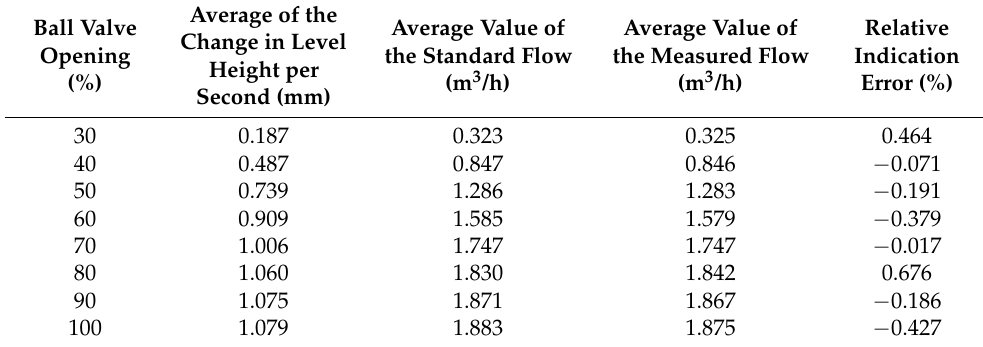
Table 4. Measurement results under DN15 pipe diameter.